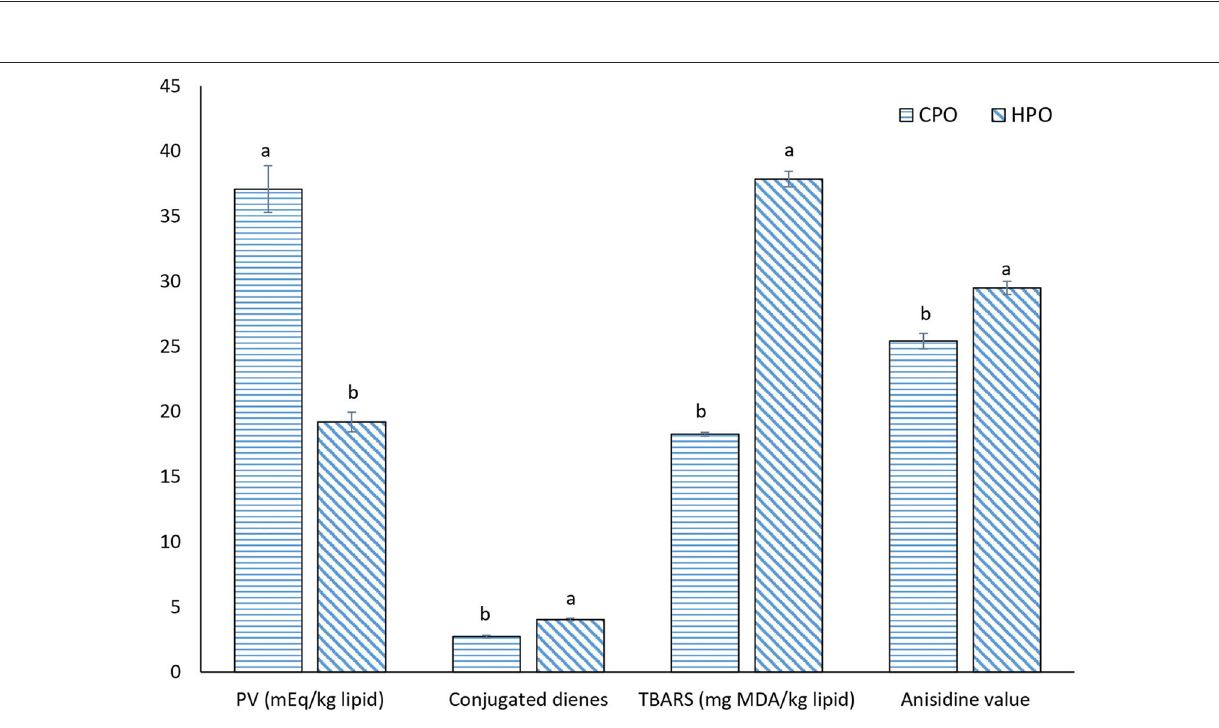
Frontiers in Nutrition |